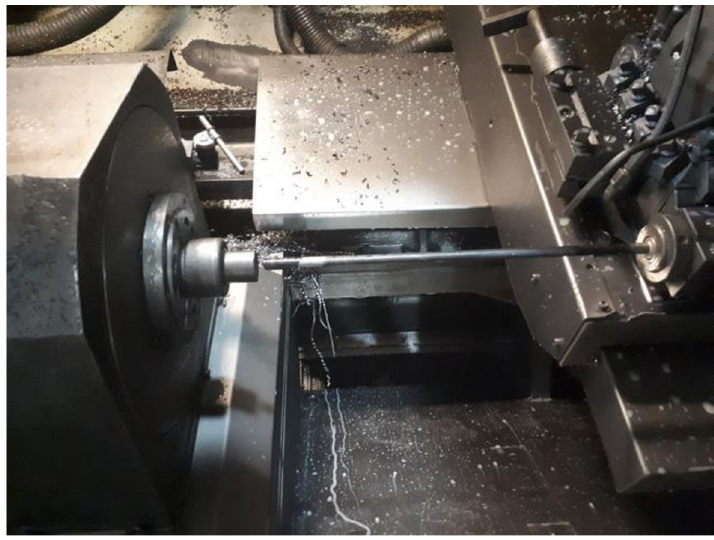
Figure 3. ZAH720 thickness planer workspace.